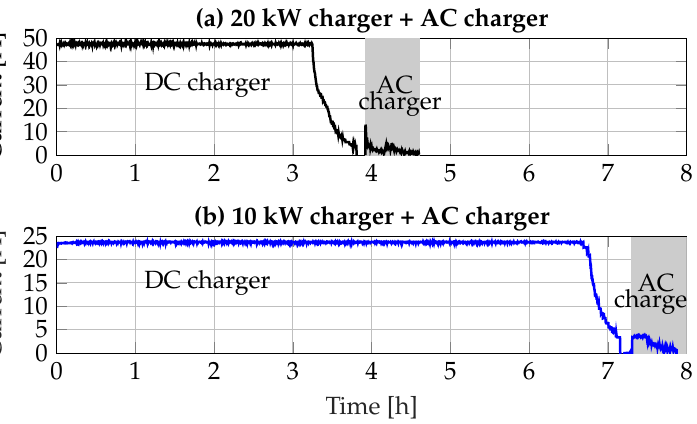
Figure 3. Current charging profiles of a 62kWh battery pack with a 10kW and a 20kW DC charger, including the final tail with an AC